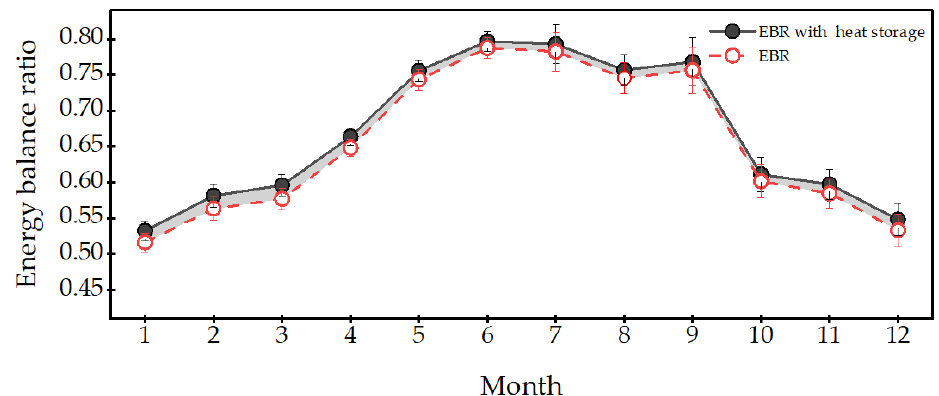
Figure 6. Average annual variation of energy balance ratio, where filled dots and solid lines indicate heat storage is considered, hollow circles and dashed lines indicate EBR without heat storage, and error bars indicate standard errors.